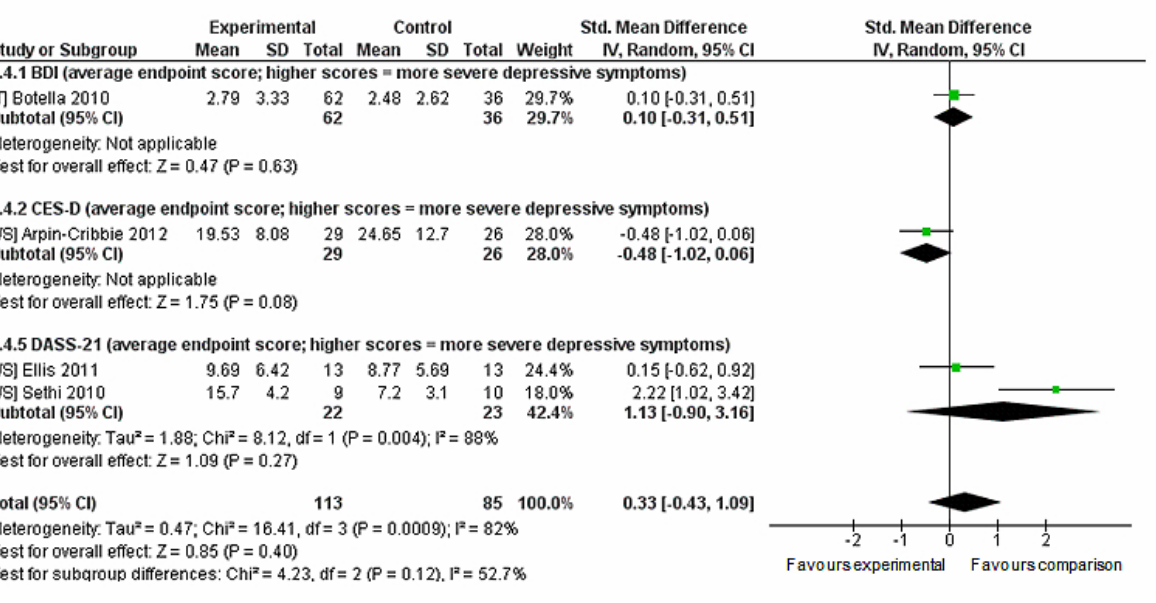
Figure 8. Sensitivity analysis of post-intervention depression outcomes for intervention compared to comparison